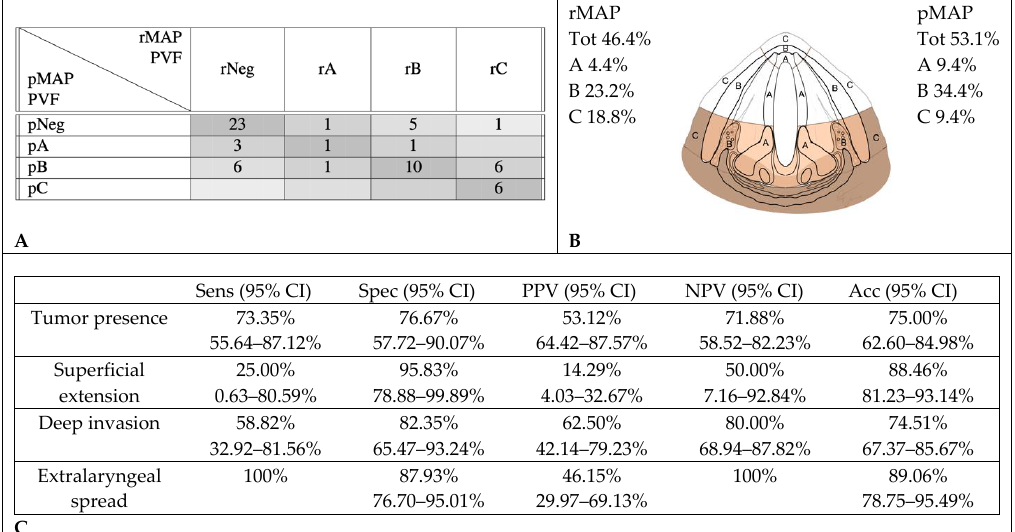
Figure 4. Accuracy in radiological assessment of posterior vocal fold (PVF) involvement. ( A ) Graphical representation of concordance between CT and histopathology in posterior vocal fold assessment. ( B ) Percentage of cancer involvement of posterior vocal fold in rMAP and pMAP. ( C ) Sensitivity (Sens), specificity (Spec), positive predictive value (PPV), negative predictive value (NPV) and accuracy (Acc) of CT in posterior vocal fold. CI: confidence interval, rMAP: radiological glottic map and pMAP: histopathological glottic map.